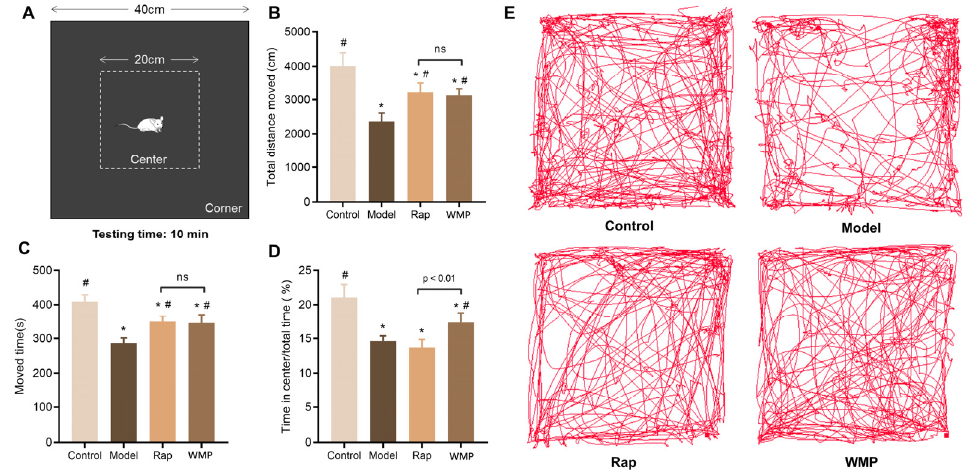
Figure 2. The effects of WMP on locomotor activity and anxiety-like behavior of mice. ( A ) Schematic representation of the open field test, ( B – D ) The total distance moved, moved times and the number of times the mice entered the center the open field, respectively, ( E ) The moving trajectory of mice in each group. * p < 0.05 vs control group and # p < 0.05 vs model group; ns: not